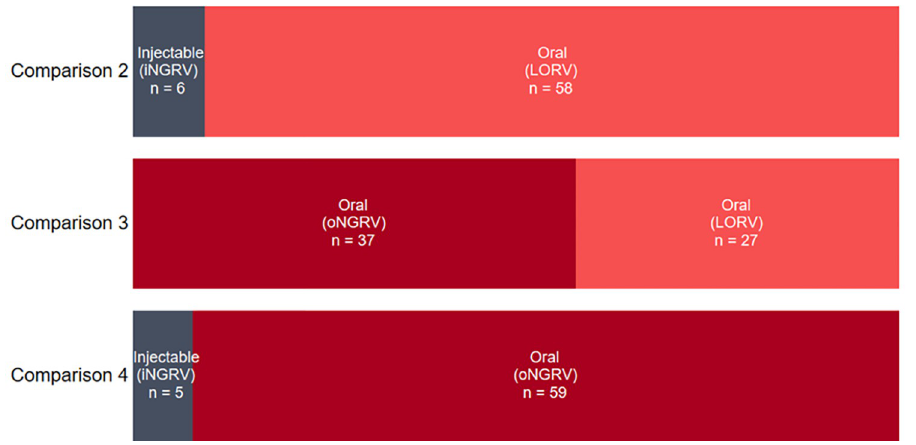
Fig 1. Healthcare provider preferences among vaccine comparisons